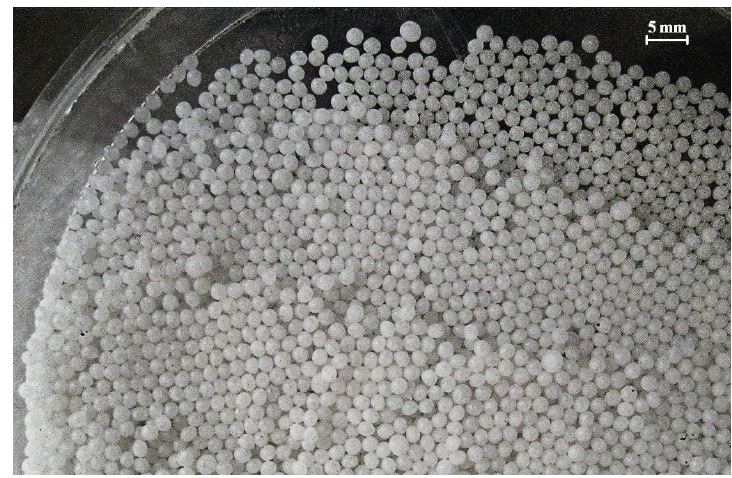
Figure 8. Prills obtained during the tests.